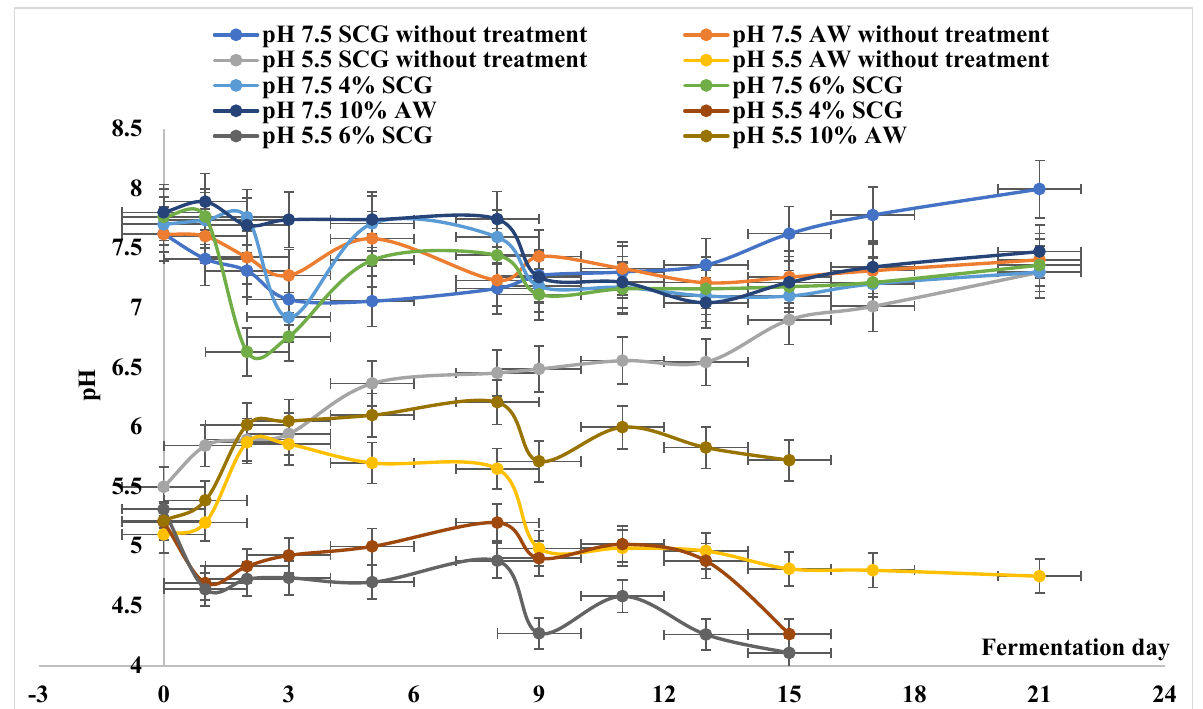
Figure 3. pH changes during batch culturing containing treated and untreated SCG and AW as a substrate. For details, see Materials and Methods section.